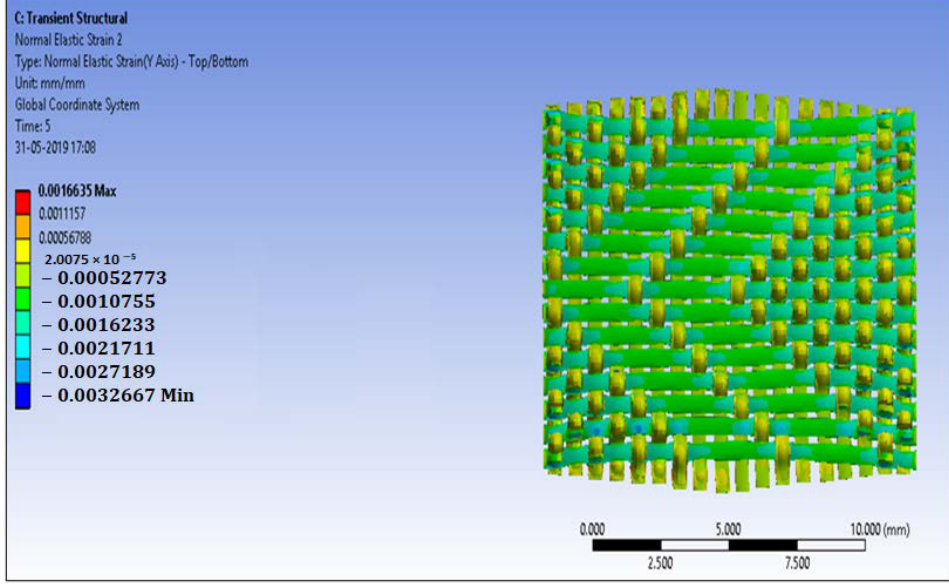
Figure 12. Elastic strain in the transverse